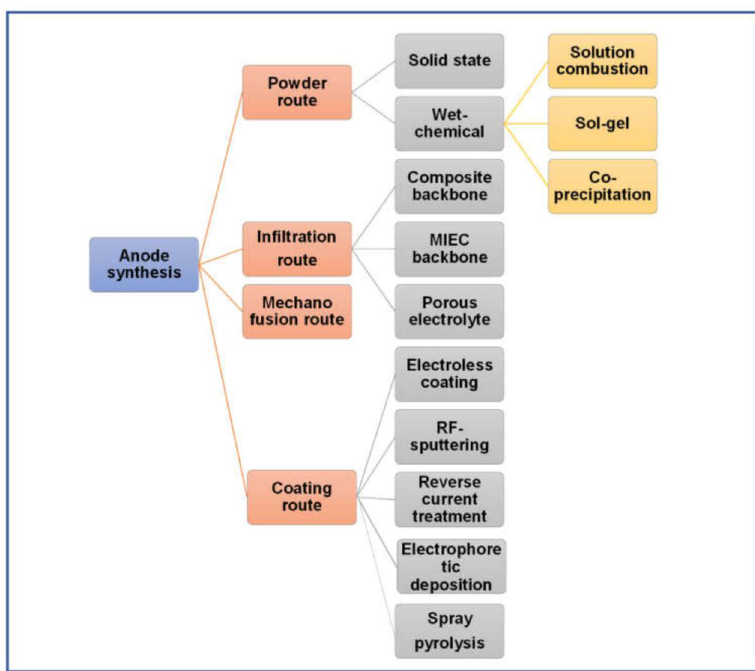
Figure 17. Flowchart showing various routes used for anode synthesis.